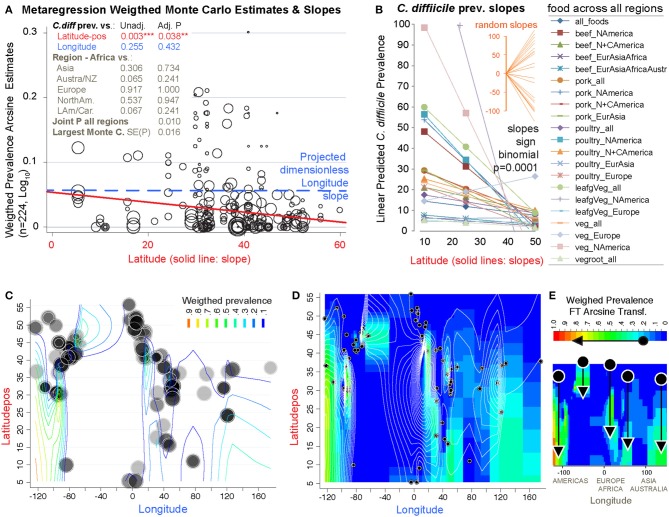
The probability of recovering C. difficile from foods increases toward the tropic. Linear correlation estimates, various meta-regression analyses controlling for confounders, contour plot simulation and Monte Carlo permutation test (n = 224, 1000 perm, joint P = 0.01) statistics revealed that latitude has been one of the most influential variables determining the magnitude and frequency by which C. difficile has been found in the human diet. (A) Moment-based estimate of between-food-set study variance and display of weighed correlation between prevalence and the absolute latitude. Without Knapp & Hartung modification to standard errors. P-values unadjusted and adjusted for multiple testing. Note that longitude is not significant variable. (B) Plot of linear trends derived from fitting linear models to actual data segregated by type of food and continents/regions aligned over distinct longitude ranges. Notice that except one slope, published reports have documented an inversed latitudinal trend. (C) Contour line plot simulation of the weighed CD prevalence for all food items over absolute latitude and real longitude plane (semi-transparent circles of different sizes, the larger the circle, the greater the influence on overall simulation). (D) Contour density and line plot simulation to help visualize the low prevalence estimates (near zero = blue) and latitudinal trends. Circles represent the location of the research centers were the studies were conducted or the centroid for the region that was sampled. (E) Contour density simulation to illustrate that latitudinal trends (arrows) can cover different latitudinal ranges, depending on the region (e.g., short high arrow corresponds to Europe). In iterative simulations, it is to note that such density latitudinal trends tend to cluster between two extreme arrangement patterns but that the significance is independent of the region (Supplementary Figures 6, 7 for further details and statistics).